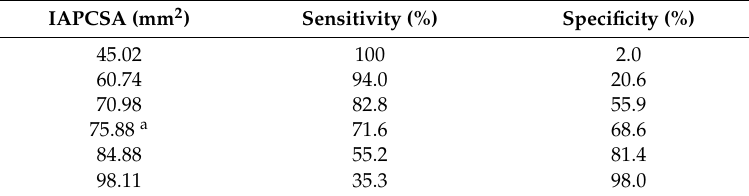
Table 4. Sensitivity and specificity of cut-o ff value of IAPCSA.